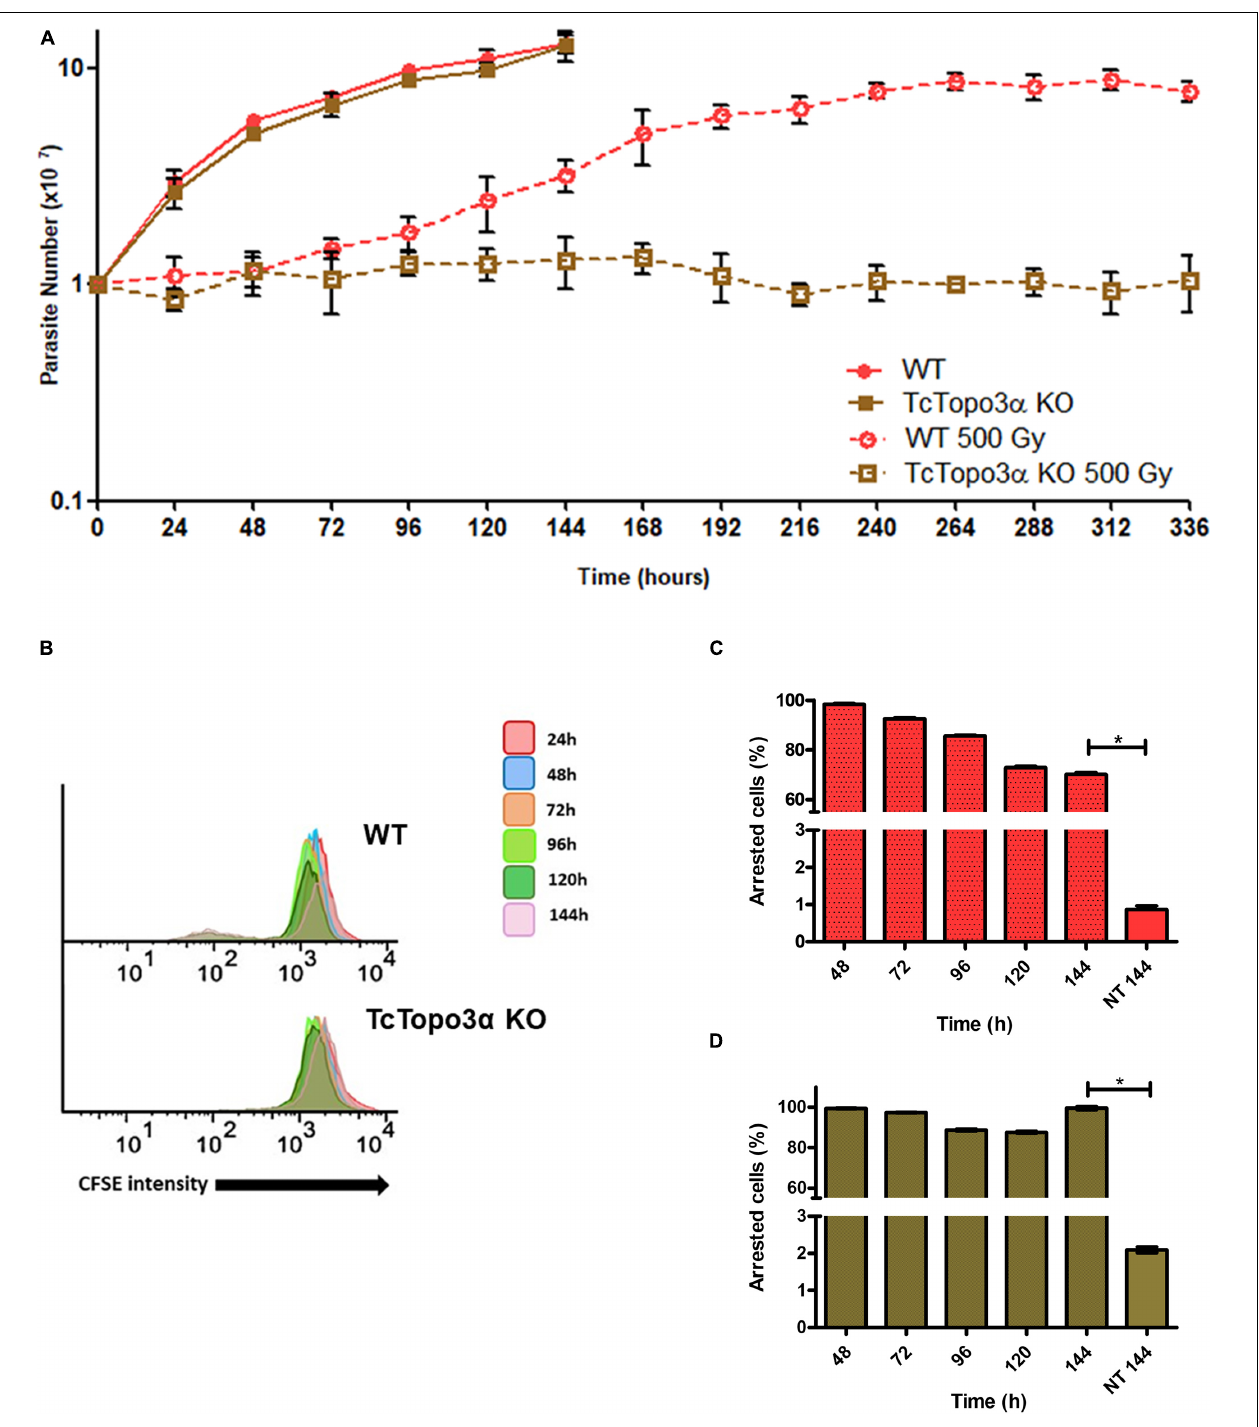
FIGURE 3 | Growth curve and dormancy after gamma radiation. (A) Evaluation of the growth profile of WT and TcTopo3 α KO T. cruzi epimastigotes parasites after exposure to 500 Gy of gamma radiation. The parasites were cultured in LIT medium at initial concentration of 1 × 10 7 cells ml - 1 and counted in a cytometry chamber every 24 h. The experiment was performed in triplicate. (B) Flow cytometry histograms of CFSE fluorescence intensity decay over time from epimastigotes exposed to 500 Gy. Cells that have similar CFSE fluorescence intensity compared with the level of half median at time point of 24 h were considered as arrested. (C,D) The graph shows the percentage of WT (C) or TcTopo3 α KO (D) arrested parasites determined by flow cytometry showing half of CFSE median intensity observed at 24 h of growth. The percentage of dormant parasites at 144 h – from a culture without exposure to HU (NT 144 h) is shown for the sake of comparison. Representative results of three distinct experiments in three technical triplicates. Asterisks indicate statistically significant differences among groups ( p -value < 0.05).